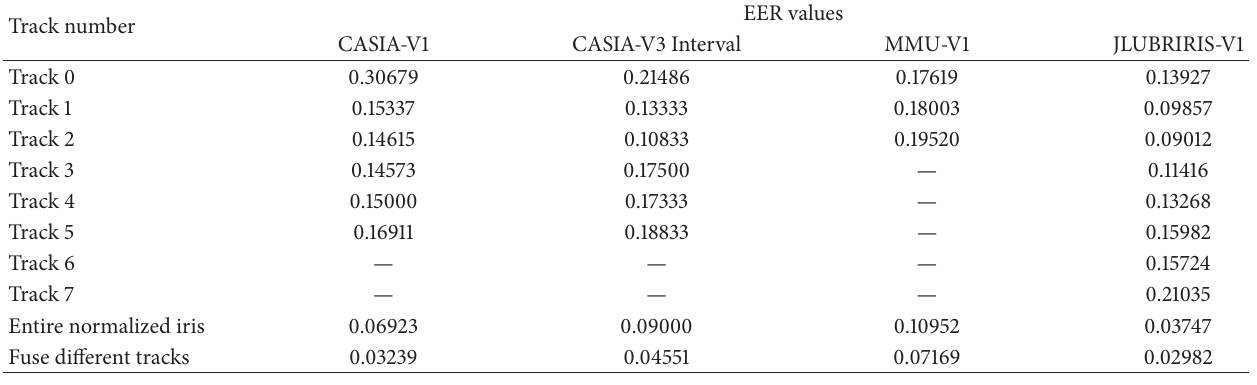
Table 8: EER of different tracks.